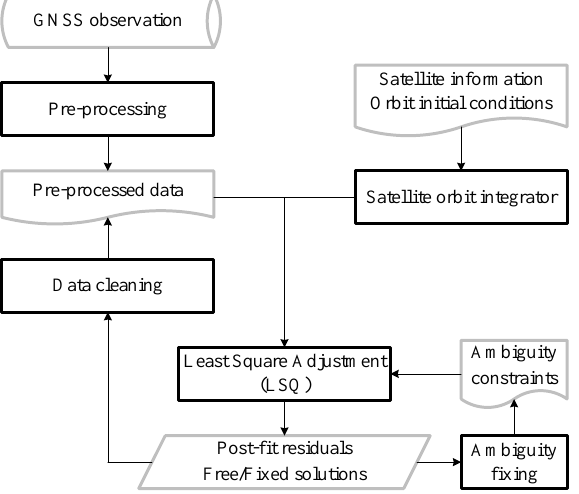
Figure 4. Procedure for precise orbit determination